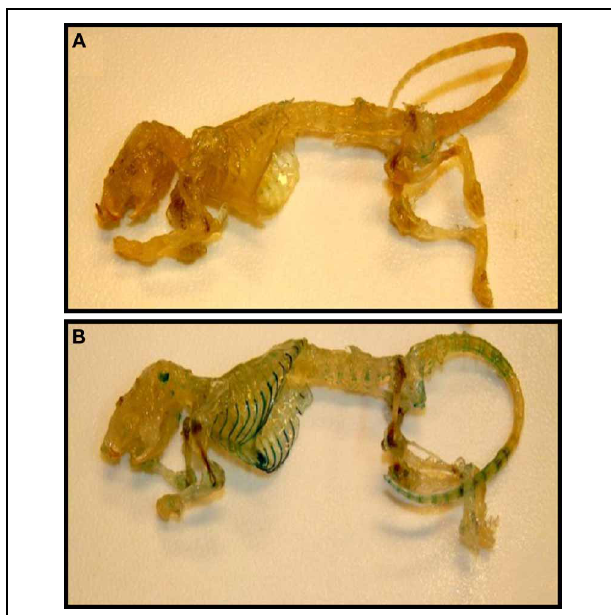
FIGURE 3 | Cartilage as a site of TASK-2 expression revealed by β -galactosidase activity in TASK-2 KO mice. Skeletons from WT (A) and TASK-2 KO (B) mice were prepared by clearing and decalcification followed by staining for X-gal (blue). The KO mouse was generated by a gene-trap approach where the trapping vector encodes a β -galactosidase/neomycin resistance fusion protein (Araki et al., 2009). The enzyme is expressed under the control of the TASK-2 promoter and therefore the β -galactosidase activity reflects sites of endogenous TASK-2 gene expression. FIGURE 4 | TASK-2 expression in hyaline cartilage from trachea and